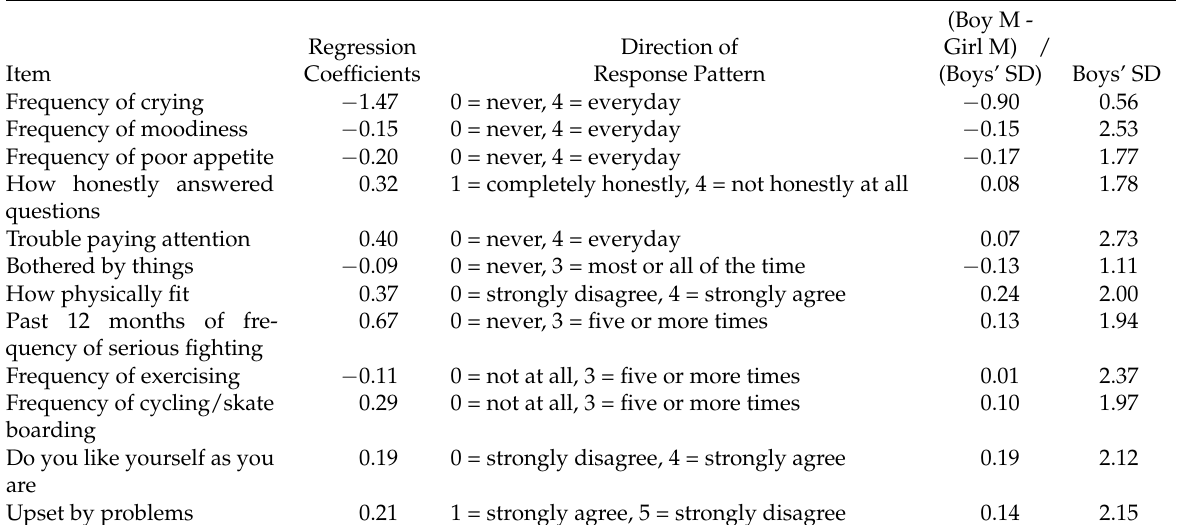
Table 1: Questionnaire items for the gender typicality